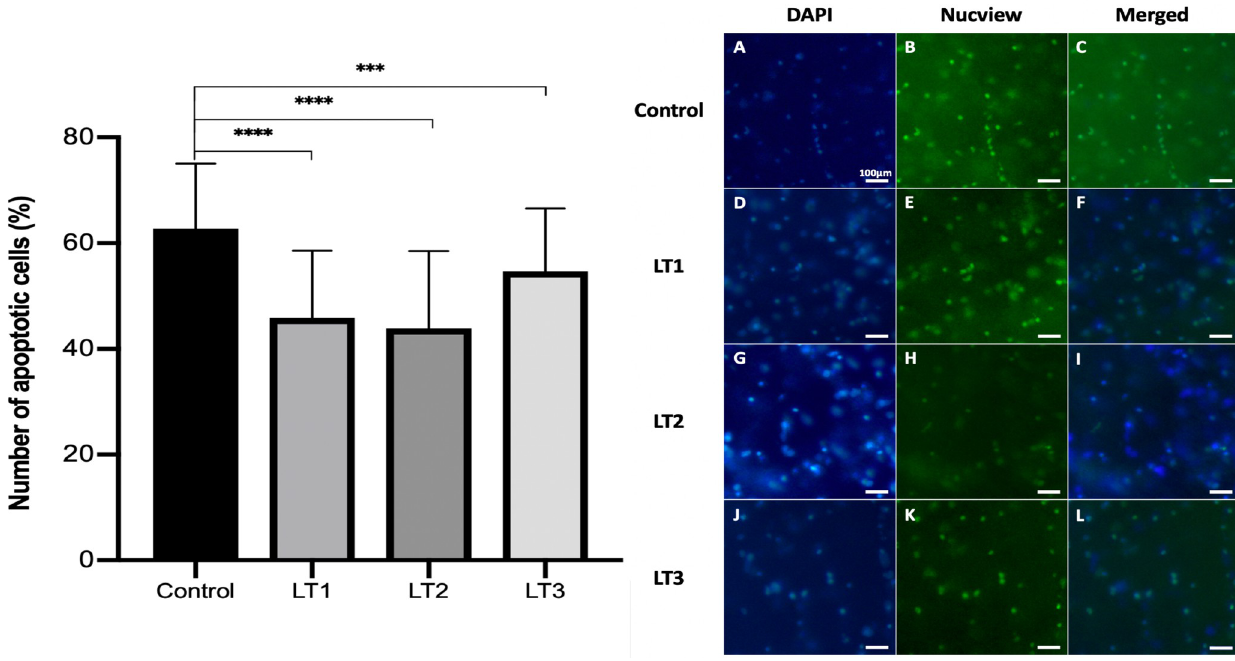
Fig 5. Effect of irradiance—% of apoptotic cells in each group, LT1 = 21 . 3 mW/cm 2 , LT2 = 42 . 4 mW/cm 2 , LT3 = 85 . 0 mW/cm 2 . ���� denotes P < 0.0001, ��� denotes P < 0.001, �� denotes P < 0.01, error bars represent SD. DAPI = 4’, 6-diamidino-2-phenylindole.